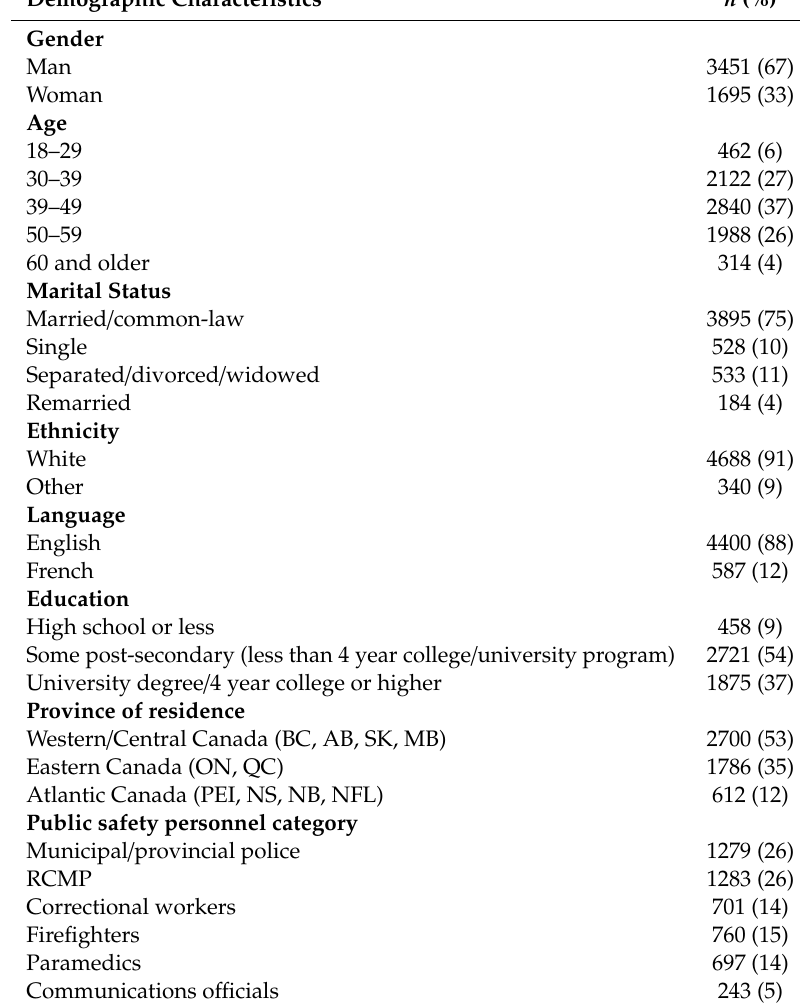
Table 1. Demographic Characteristics among Public Safety Personnel in